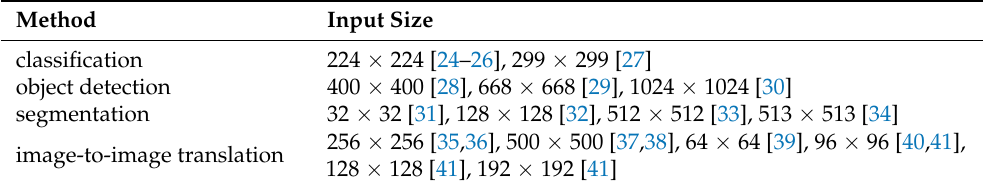
Table 1. Sample dimensions of the input layers used in processing satellite